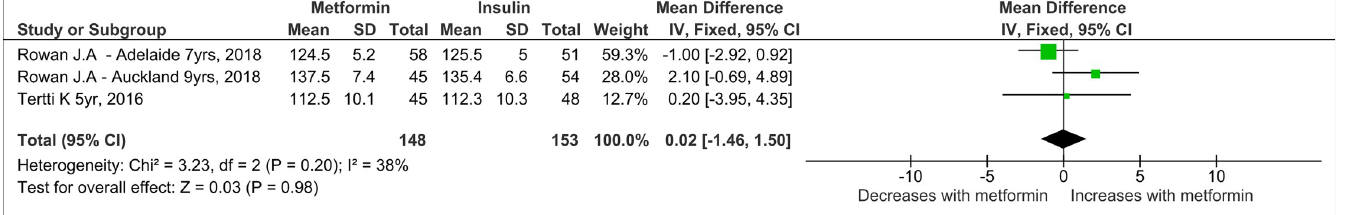
Fig 15. Childhood height. Expressed as mean differences (fixed effects model) and 95% CI. IV, mean difference.